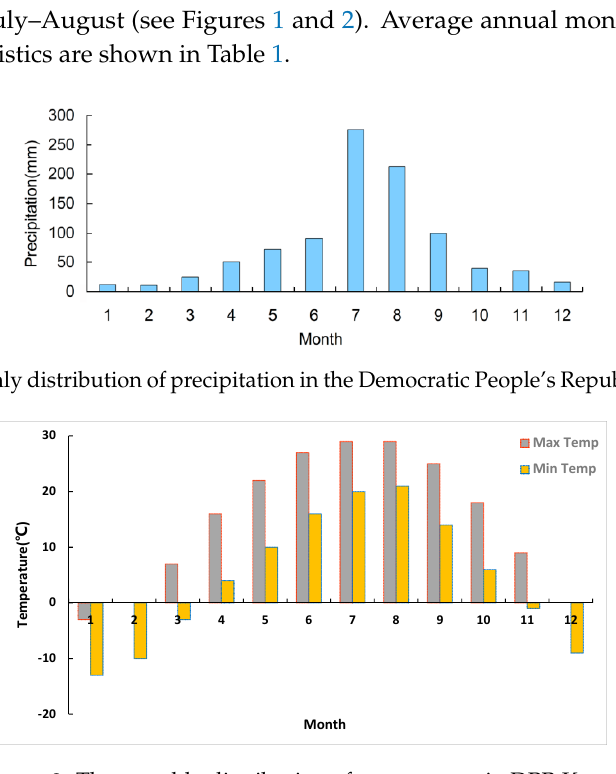
Figure 2. The monthly distribution of temperature in DPR Korea. Table 1. The average annual temperature and precipitation in DPR Korea.